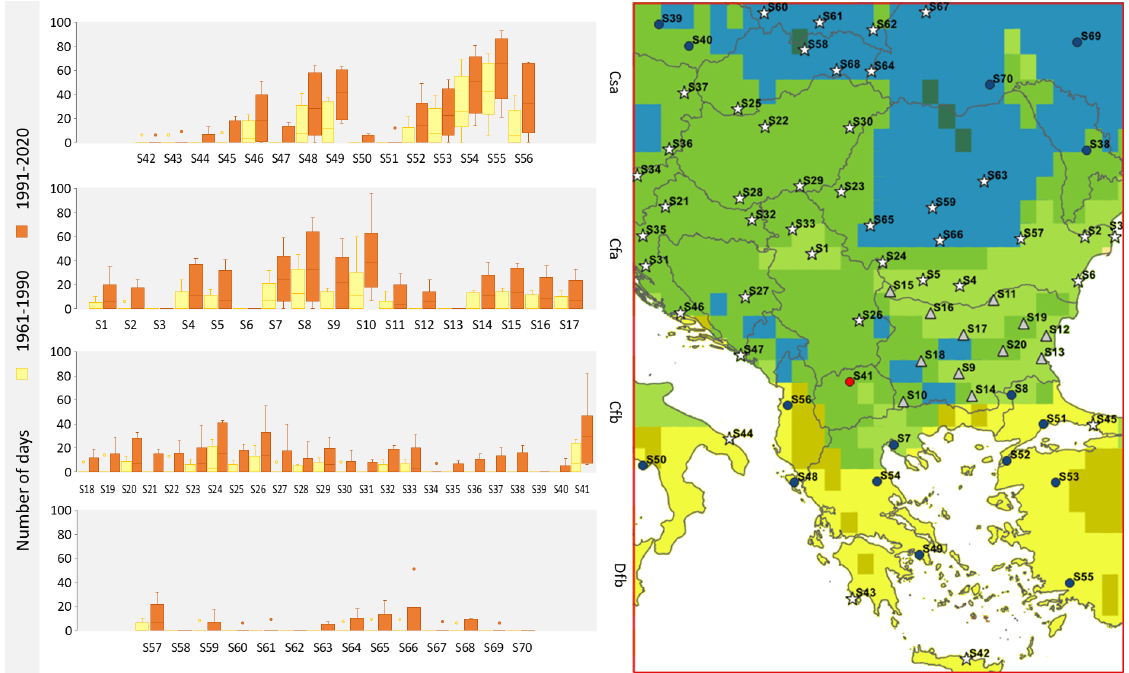
Figure 6. Left panel: Box plots of the hsd32 statistics for the periods 1961–1990 and 1991–2020 by stations grouped by the Köppen–Geiger climate classification zones. Right panel: Location and ID (Appendix A, Table 1) of meteorological stations used in the study on the background of the Köppen–Geiger classification for SEE (see Figure